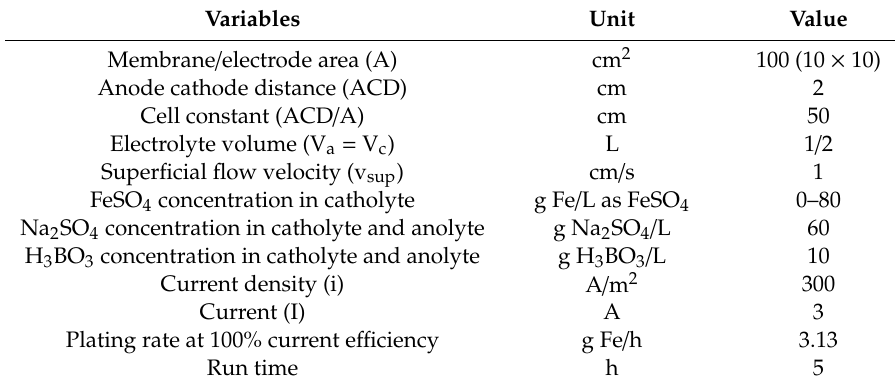
Table 1. Standard electrowinning